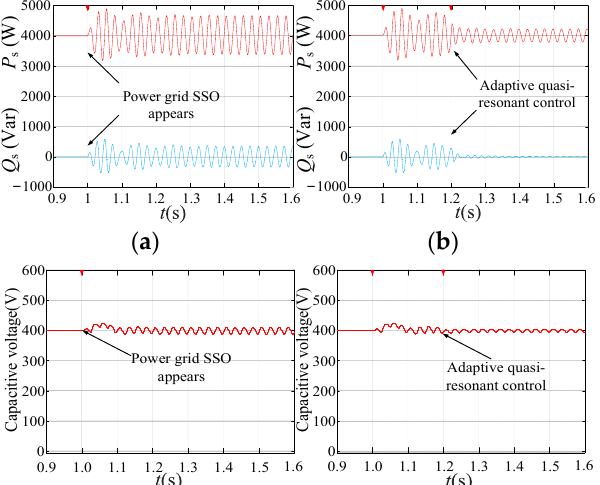
Figure 12. Comparison of stator power and capacitance voltage waveforms before and after SSO suppression: ( a ) power before the SSO inhibition; ( b ) power after the SSO inhibition; ( c ) V dc before the SSO inhibition; ( d ) V dc after the SSO inhibition.